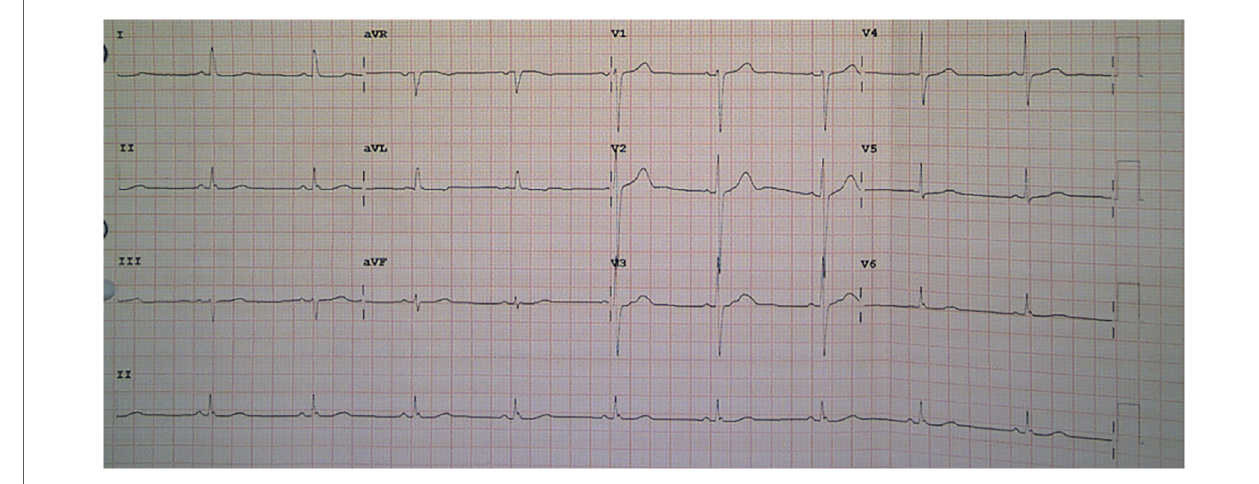
FIGURE 3 Repeated ECG revealed normal heart rate without ST-T changes after diltiazem treatment. ECG, electrocardiogram.